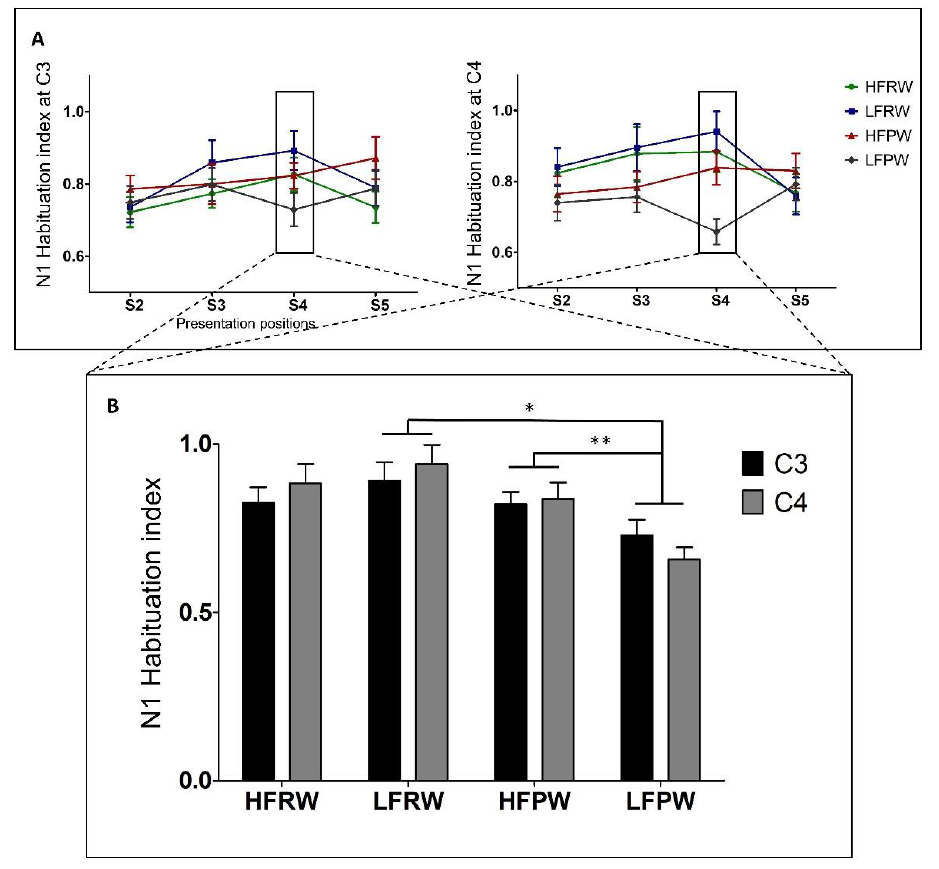
Figure 3. The phonological modulation effects of N1 habituation. (Panel A ) demonstrates the N1 habituation indexes in the four conditions, in each stimulation position, at C3 and C4. (Panel B ) depicts the N1 habituation indices in S4 and the significant interactive effects between lexicality and usage frequency. The error bars represent the standard error of the mean (SEM), * p < 0.05, ** p < 0.01. The inferential statistical analyses with the habituation-index data first revealed a main effect of LEXCIALITY ( F (1, 29) = 9.249, p = 0.02) and a significant interaction